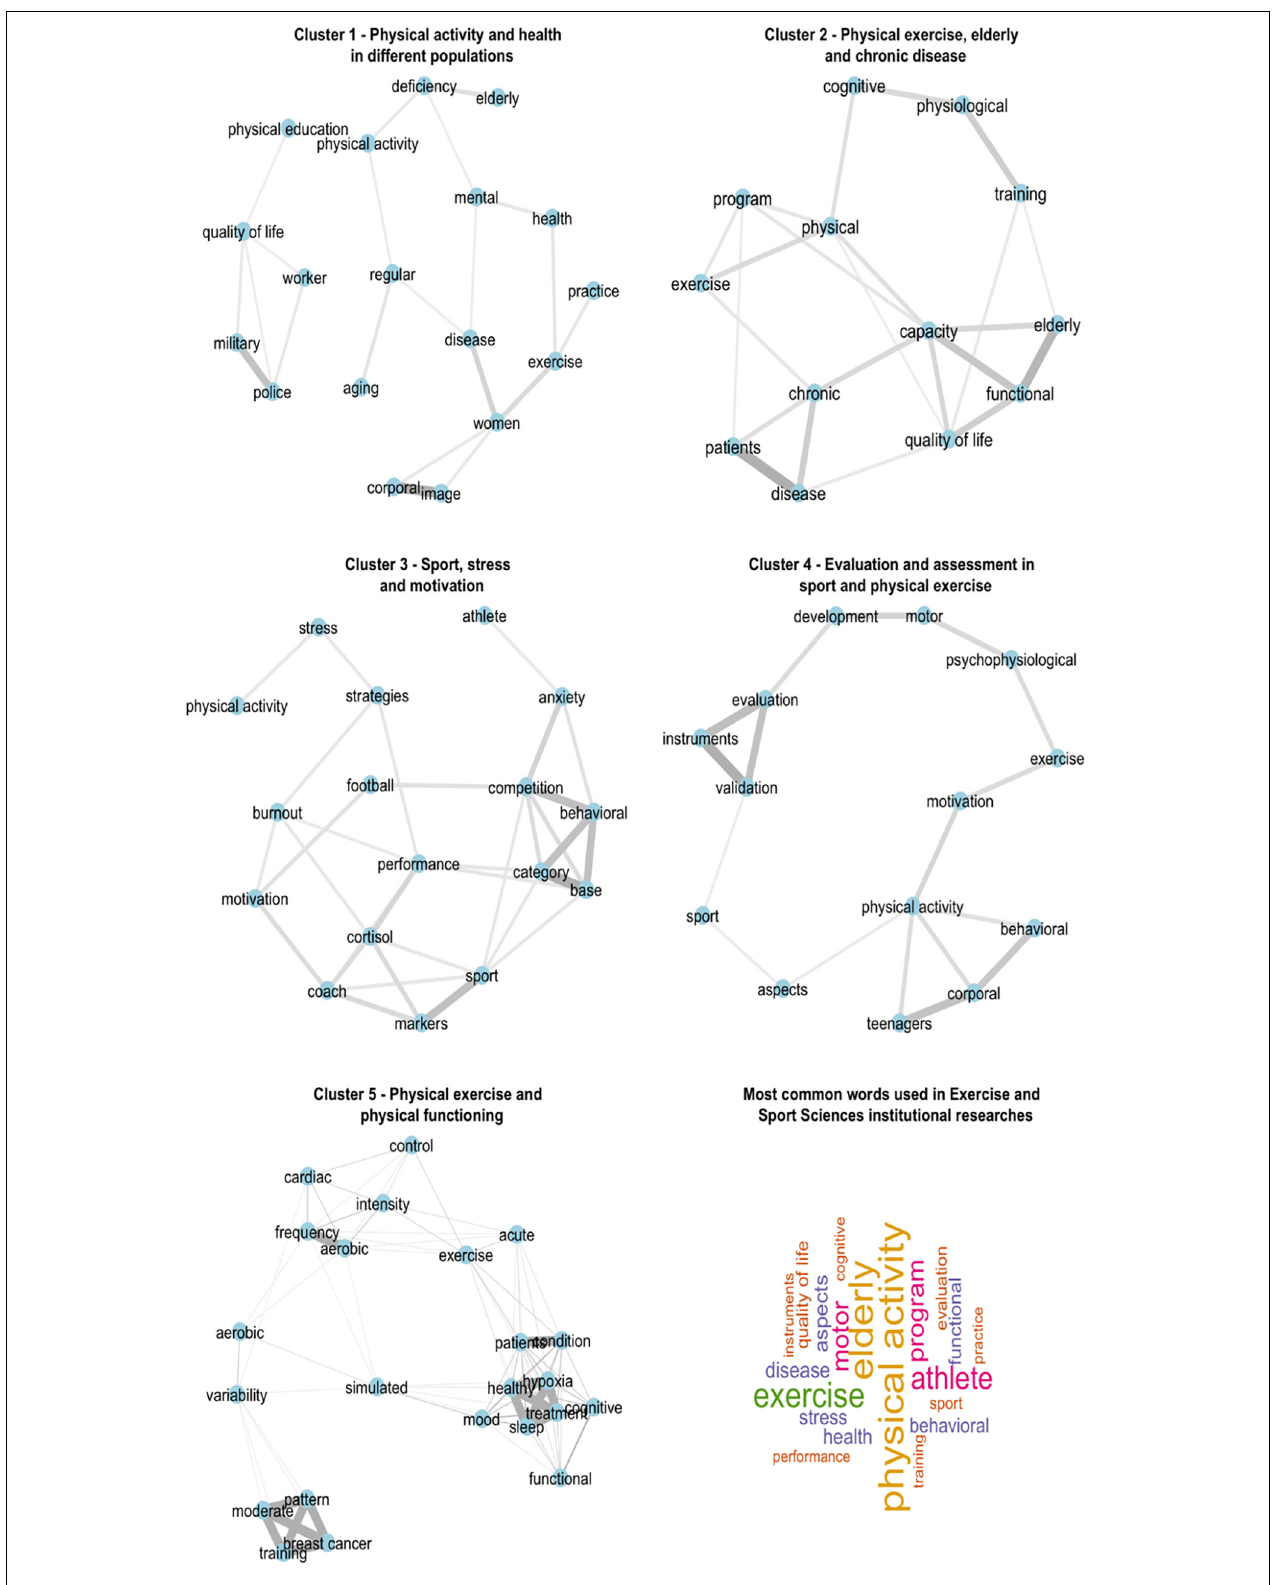
FIGURE 4 | Correlation network and a word cloud of title words of Exercise and Sport Science GPs.